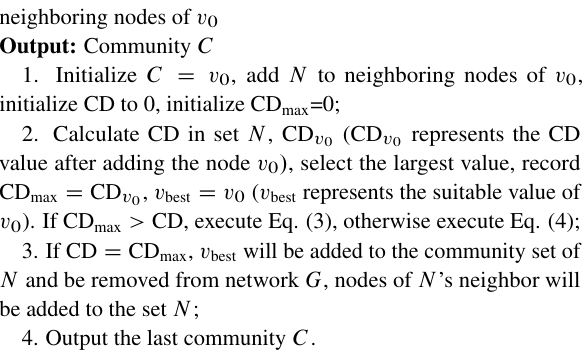
Algorithm 1 Local community discovery